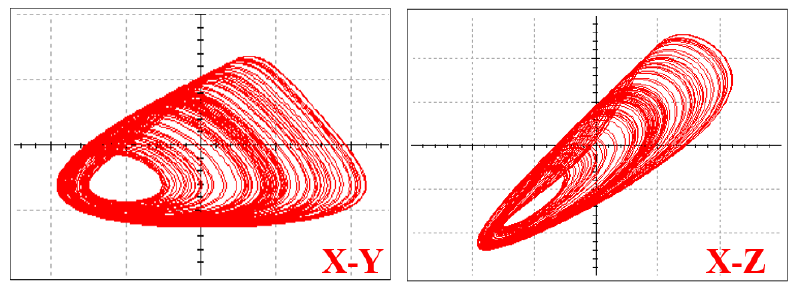
Figure 13. Chaotic attractor in the system (10) from circuit simulation.